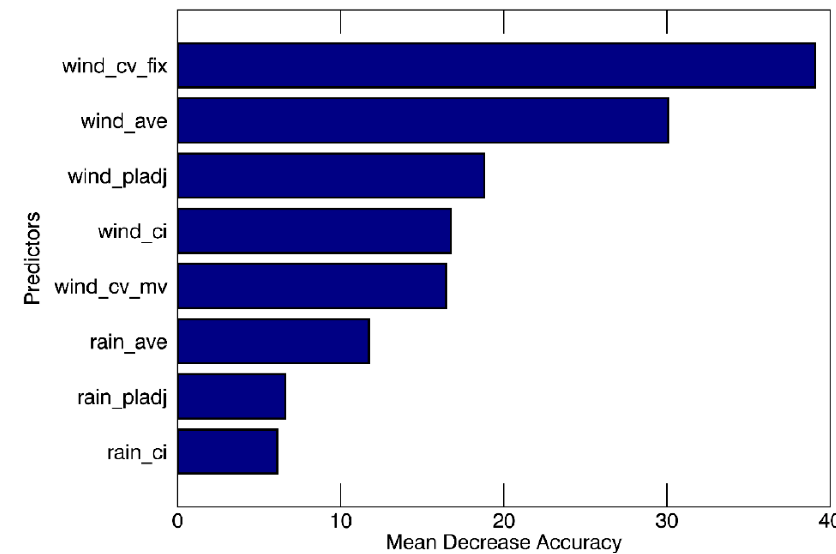
Figure 3. The averaged relative importance of predictors in random forest (RF) using 1000 different training datasets. The importance is measured as the mean decrease accuracy, which indicates the accuracy decrease when a specific predictor is deselected.